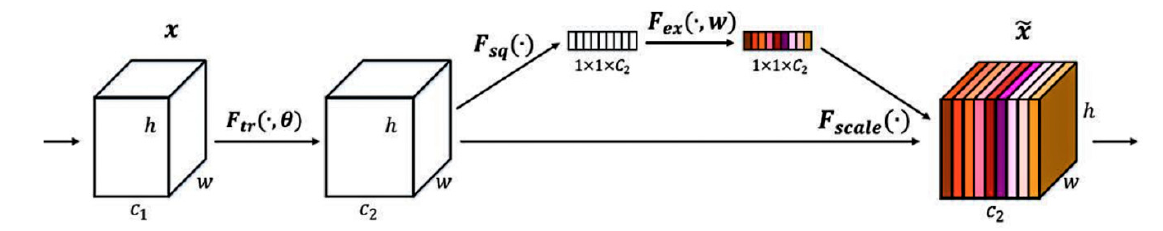
Figure 4. Attention module [30].